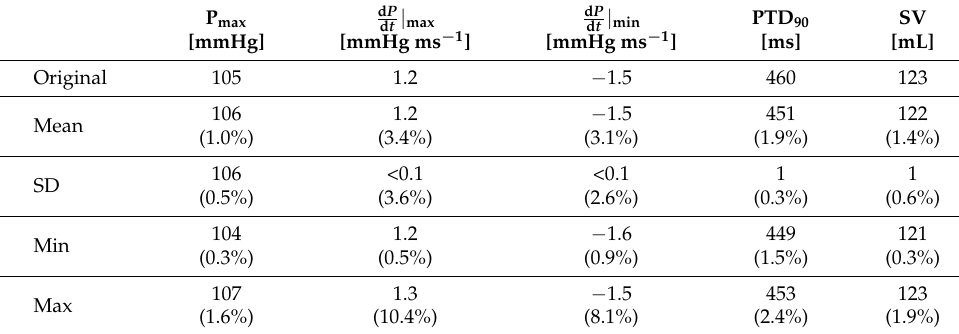
Table 8. Results of the initial guess variation robustness analysis for the patient case 02-CoA. Pressure and volume biomarker values of the first step of the active mechanics personalisation approach are given. The original values produced by the default initial guesses are listed in the first row and means (M), standard deviations (SD), minima (Min), and maxima (Max) of five samples are listed in the subsequent rows. Means, standard deviations, minima, and maxima of the relative differences are given in brackets below.